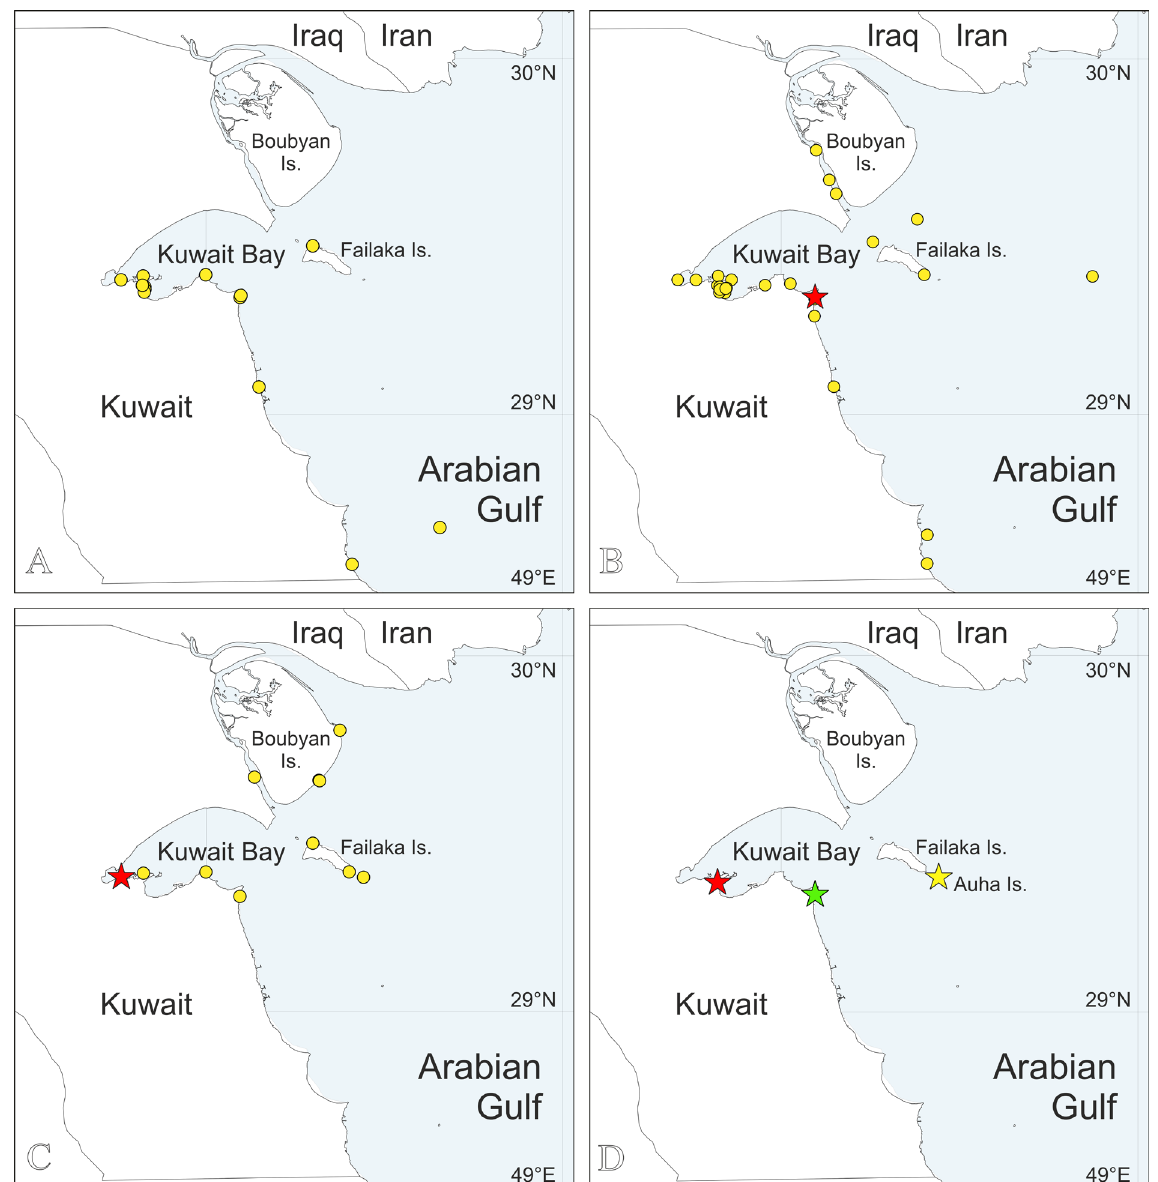
Fig. 1. Maps showing records (yellow circles) and type localities (stars) of Pseudopolydora spp. from the Arabian Gulf, Kuwait (see Supp. Table ESM1). A . P. antennata (Claparède, 1868). B . P. arabica Radashevsky & Al-Kandari, 2020 (red star = type locality: Al-Salmiya, Kuwait). C . P. kuwaiti sp. nov. (red star = type locality: Al-Judailiat). D . Yellow star = type locality of Pseudopolydora auha sp. nov.: Auha Is.; red star = type locality of P. melanopalpa sp. nov.: Sulaibikhat Bay; green star = type locality of Pseudopolydora multispinosa sp. nov.: Al-Salmiya,